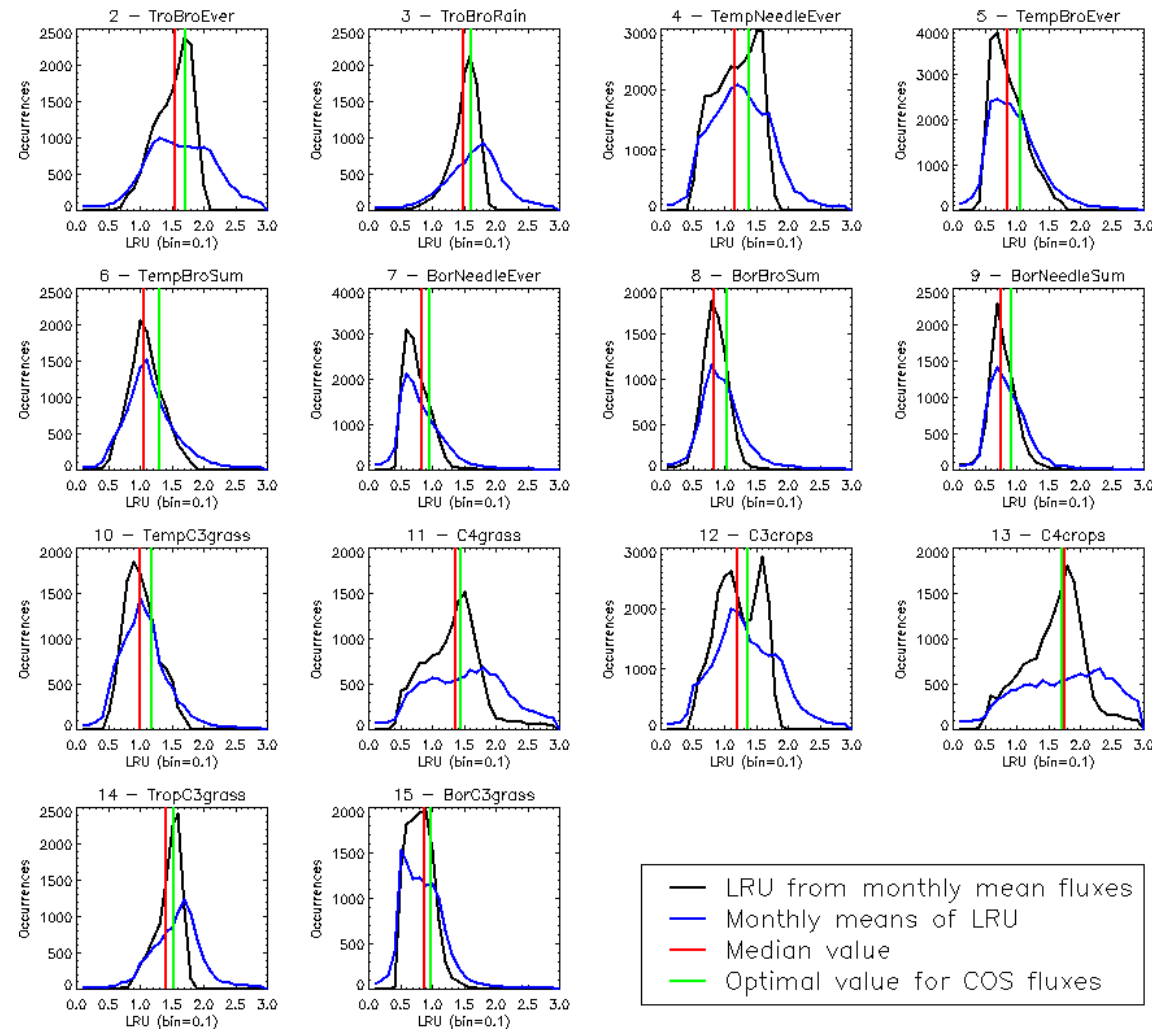
Figure 6. Distributions of the LRU values computed from the mechanistic approach over the 2000–2009 period. Each subplot represents one of the 14 vegetated PFTs used in ORCHIDEE, considering all grid cells where the PFT is present. The x axis represents the LRU value between 0 and 3, with 0.1 bins. The y axis represents the occurrences. For each PFT, the black distribution is computed using a monthly climatology of simulated COS and GPP fluxes (LRU_MonthlyFluxes), the blue distribution is computed using the monthly climatology of LRU values estimated at the original half-hourly time step (Monthly_LRU), the red vertical bar represents the median LRU value for LRU_MonthlyFluxes, and the green vertical bar represents the LRU optimal value that minimises the error between plant COS uptakes estimated at a monthly time step by the mechanistic approach and the LRU approach, for all pixels of the considered PFT (see names and abbreviations in Table